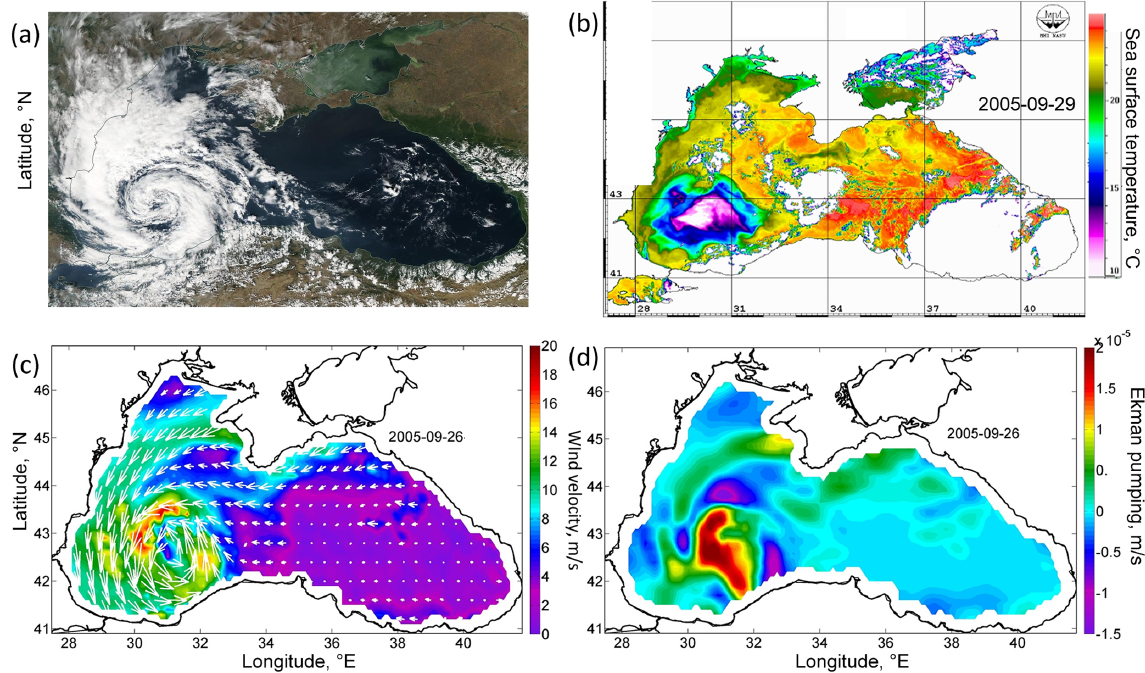
Figure 1. (a) Satellite image of MODIS Aqua in the visible range for 27 September 2005 (data obtained from the Worldview por- tal). (b) AVHRR SST (in degrees Celsius) for 29 September 2005. (c) Wind velocity (meters per second) of the scatterometer SeaWinds of the satellite QuikSCAT on 26 September 2005. (d) Ekman pumping velocity (meters per second) on 26 September 2005, calculated from QuikSCAT data (positive values indicate that the velocity is directed